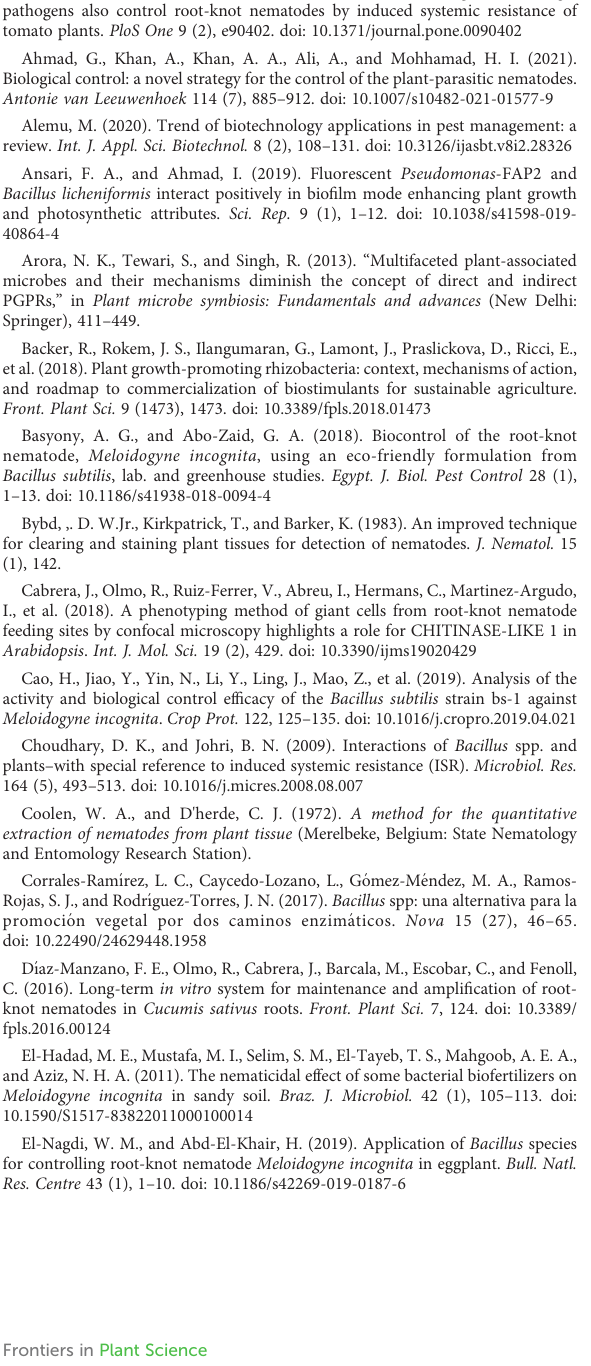
juveniles that reached the roots was assessed after 24 and 48 hours, as well as the number of juveniles inside the roots and the number of galls formed on each root. Scale bar: 2cm. SUPPLEMENTARY FIGURE 4 Sybrgreen staining of roots after bacteria treatment. (A) Non-treated roots; (B) Treated roots with a suspension of 1,0 x 10^6 CFU/ml of a dual-strain combination of B. paralicheniformis FMCH001 and B. subtilis FMCH002. Bacteria cells are indicated with the white arrows over the roots. Scale bar: 20